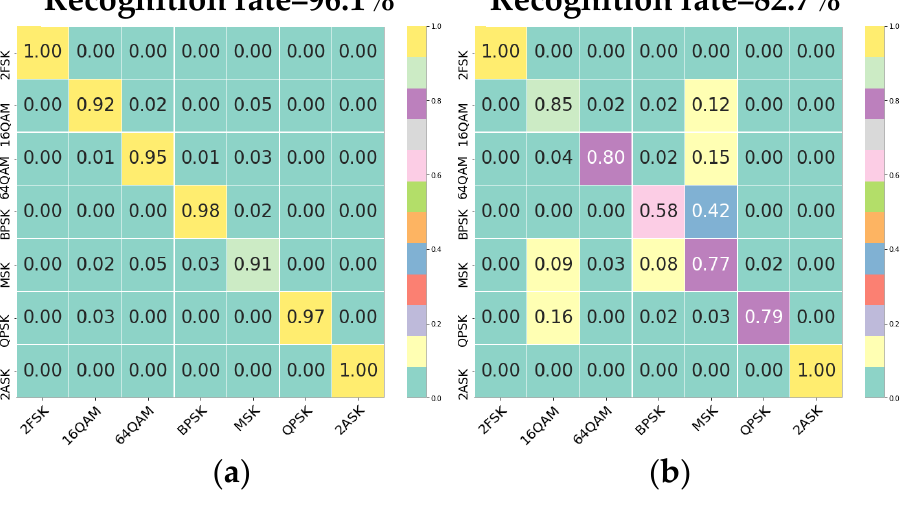
Figure 9. Multidimensional hybrid network confusion matrices. ( a ) This is the training result of dataset 1 in which the signal parameters to be recognized are consistent with those of the training set. ( b ) This is the training result of dataset 2 in which the signal parameters to be recognized are inconsistent with those of the training